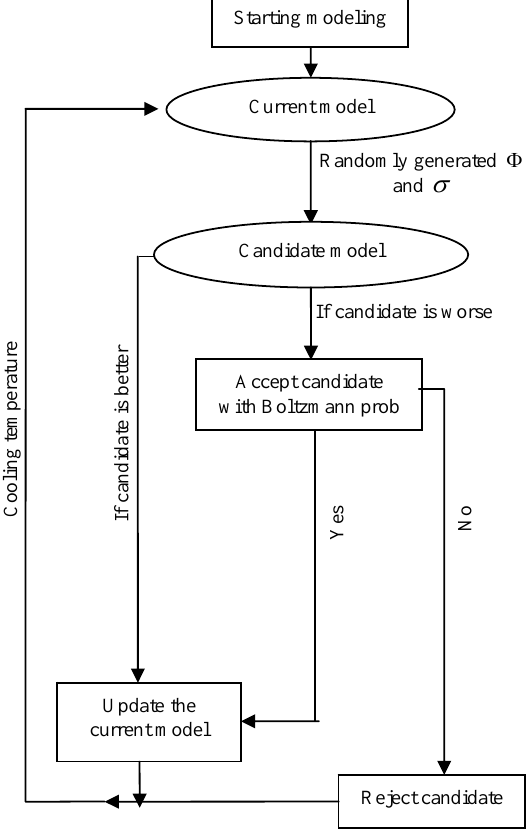
Figure 3. Simulated algorithm for roof parameters